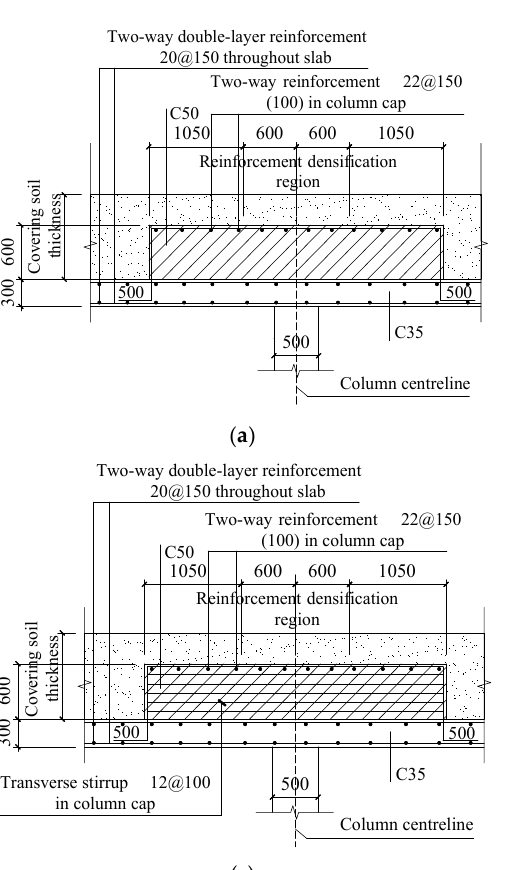
Figure 8. Specimen ZM01 (dimensions in mm).